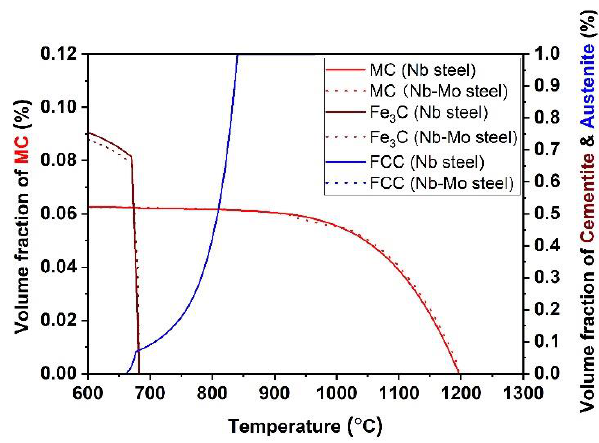
Figure 1. Volume fractions of MC, austenite, and cementite in equilibrium, as predicted by Thermo-Calc software with TCFE 9: Steels/Fe Alloys v9.0 database.